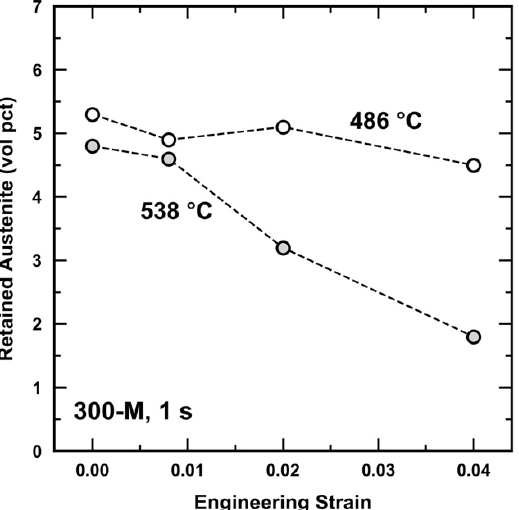
Figure 7. Retained austenite content as a function of engineering strain for the 300-M tempering conditions of 486 and 538 ◦ C (1 s). Retained austenite content is in units of volume percent determined via X-ray diffraction.